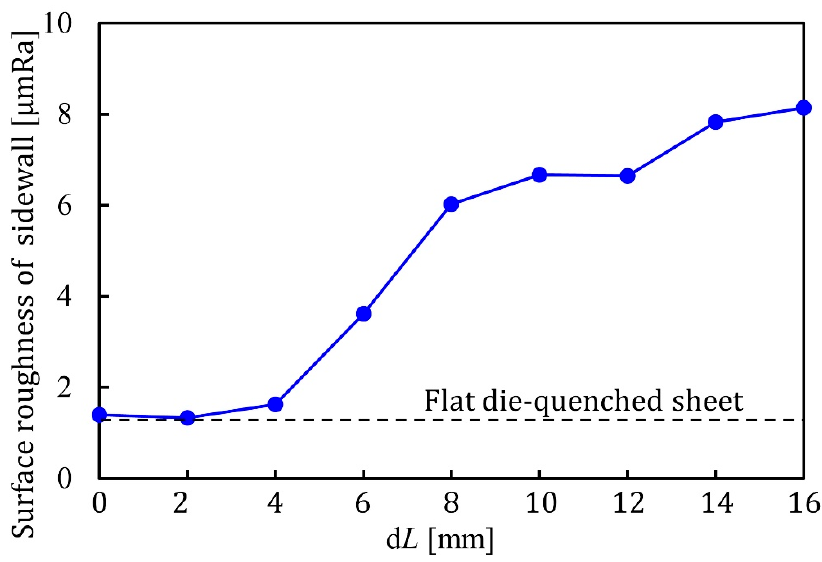
Figure 20. Relationship between surface roughness of sidewall and additional length of blank.